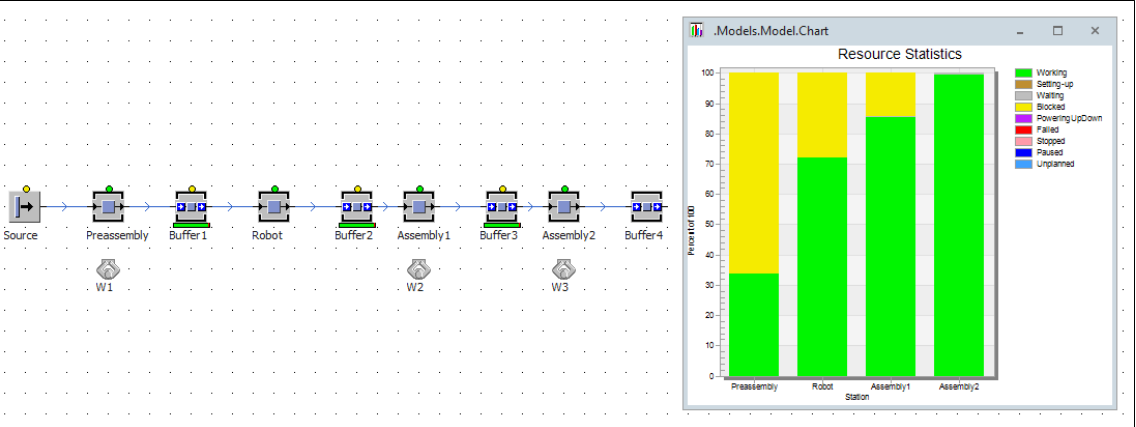
Figure 4. Variant 1a (one robot, three people).